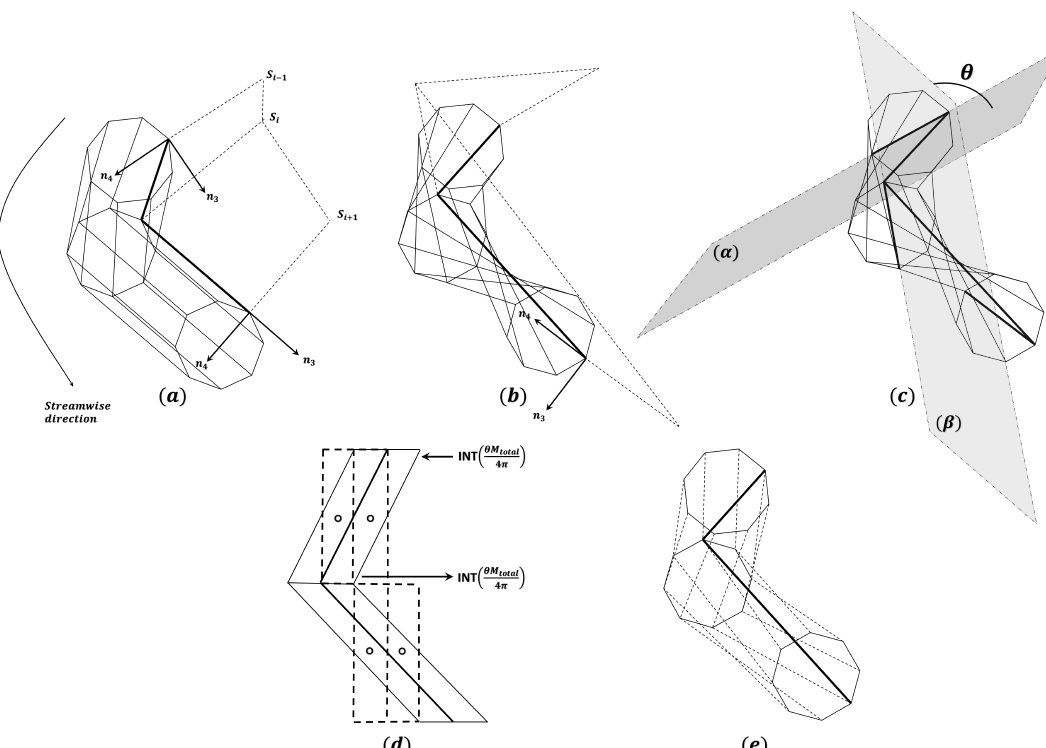
Figure 10. Initial guess of tip vortex cavity with n 3 and n 4 the local coordinate axes along the streamline in the trailing wake and the cross flow direction, respectively ( a ); distortions. of tip vortex cavity panels due to the rollup in the wake ( b ); a non-zero dihedral angle θ between the two adjacent planes α and β ( c ); adjusted panel perimeters ( d ) and updated cavity panels ( e